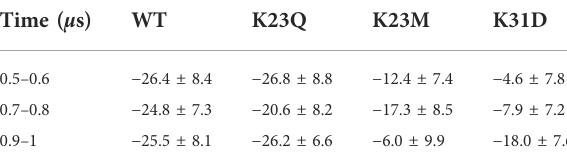
TABLE 2 Average and standard deviations (in kcal/mol) of the binding energy of the RNA fragment ° GCCCUG ° G to the PCBP1 RNA- binding domain for the different protein mutants K23Q, K23M, and K31D. The values at different times along the 1- μ s trajectories.